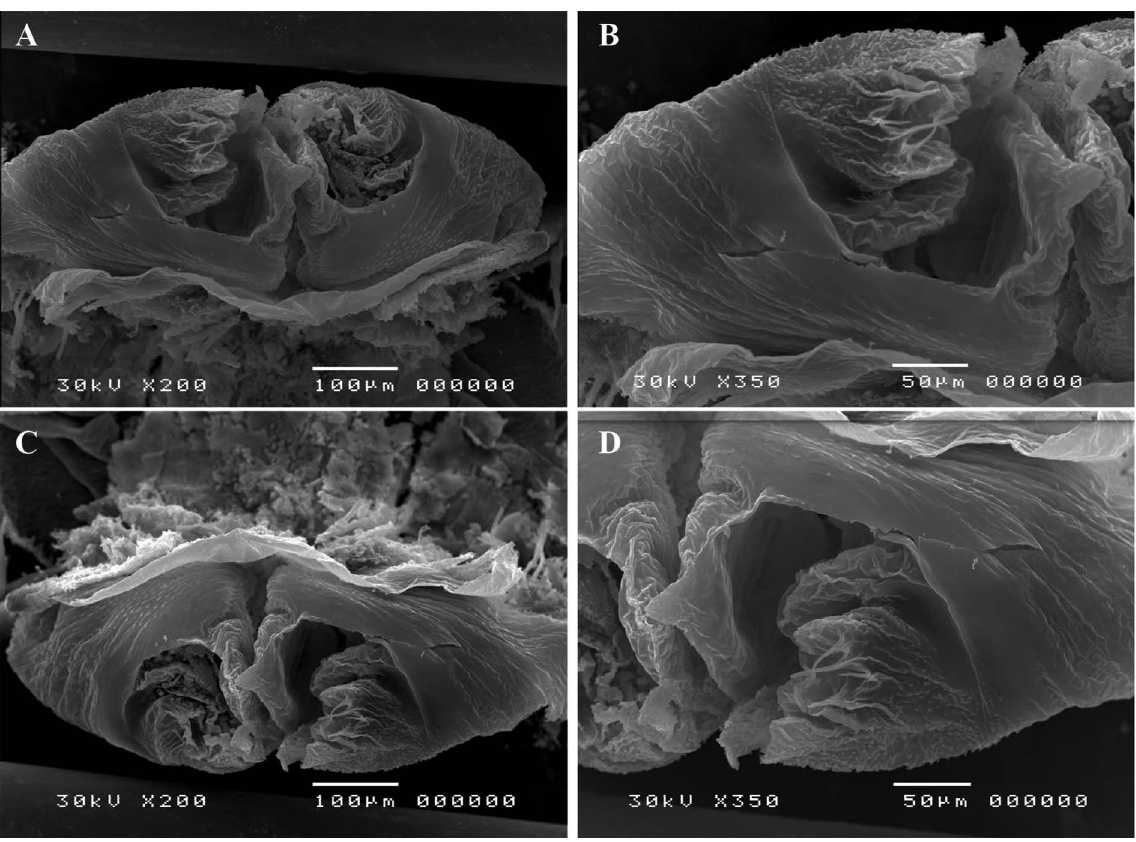
Fig. 74. Charinus renneri sp. nov. (MNRJ 9198), male gonopod. A . Ventral view. B . Lateral lobe 2, lamina medialis, processus internus and fistula. C . Posterior view. D . Lateral lobe 2, lamina medialis, processus internus and